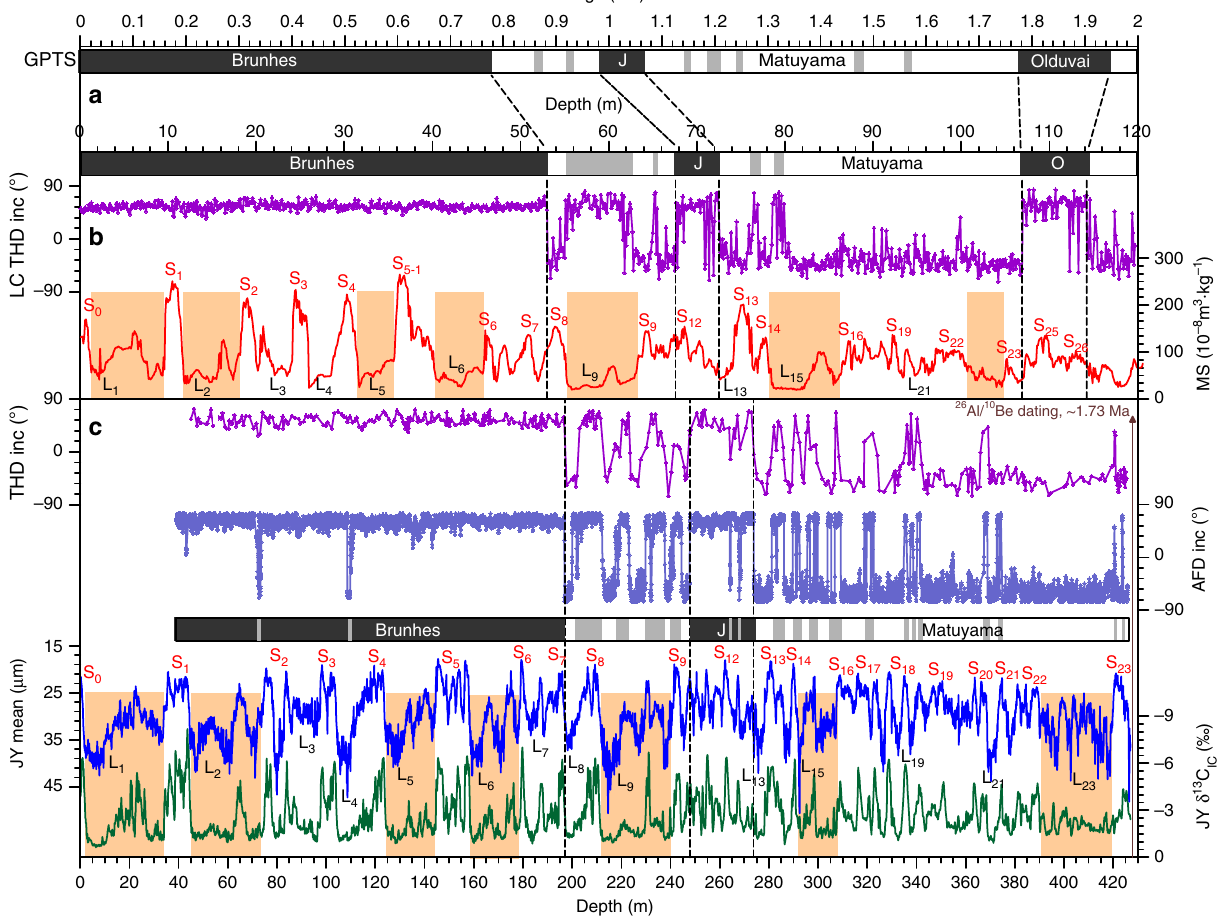
Fig. 2 Polarity and proxy variations of the JY loess sequence. a Geomagnetic polarity timescale (GPTS) 32,33 . b Magnetic susceptibility (MS) and magnetostratigraphy of Luochuan (LC) pro fi le 27,31 . c JY δ 13 C IC , mean, and magnetostratigrahy. The magnetostratigraphy is derived from inclination results measured by the alternating- fi eld (AFD, light blue) and thermal (THD, purple) demagnetization methods. Dashed lines indicate the positions of paleomagnetic reversals (B/M Brunhes/Matuyama boundary, J Jaramillo, O Olduvai). Orange bars denote thick loess marker